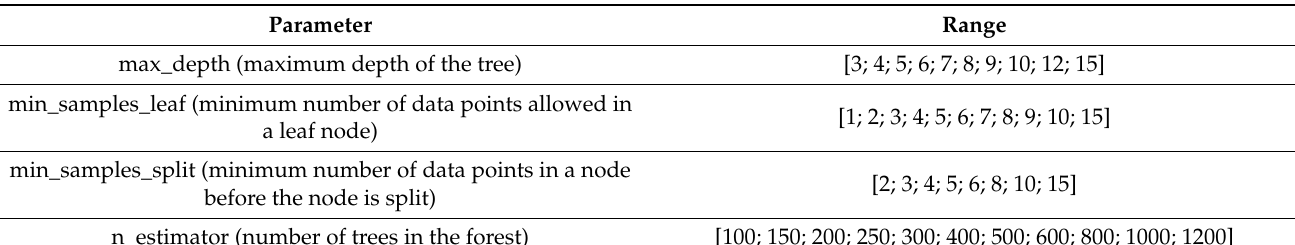
Table 4. Parameter search space in grid search analysis.